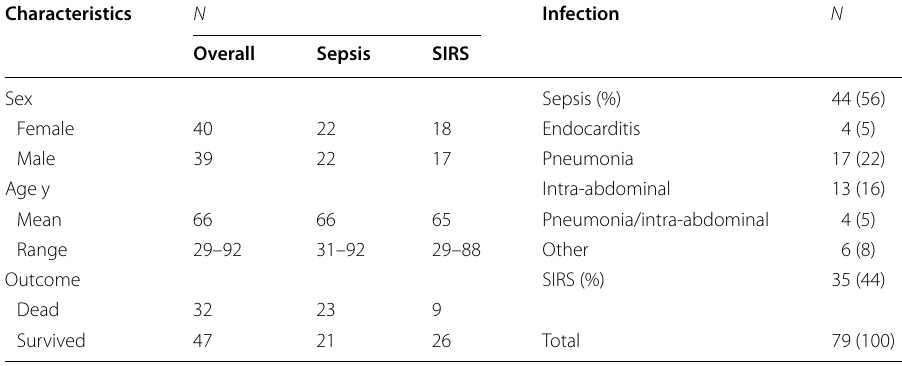
Table 1 Patient characteristics and pathologies in the investigated study population Characteristics